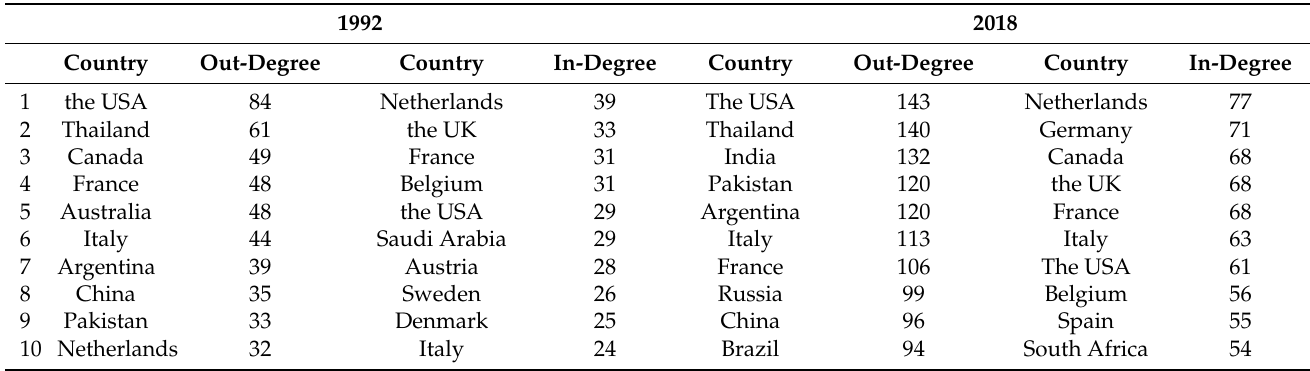
Table 3. Top countries by degrees from 1992 to 2018.